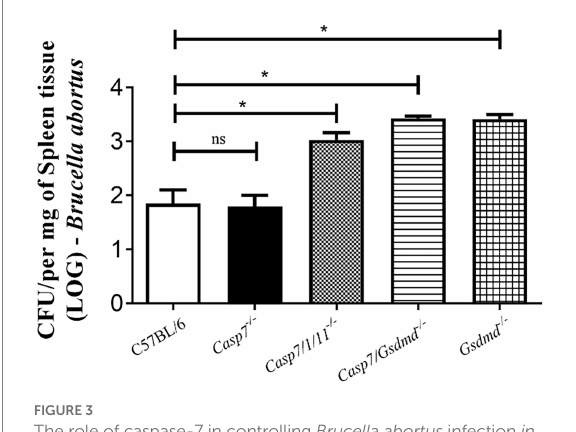
FIGURE 3 The role of caspase-7 in controlling Brucella abortus infection in vivo. Mice were infected intraperitoneally with 1 × 10 6 CFU of B. abortus and sacrificed after 2 weeks of infection, and spleen homogenates were seeded onto plates containing BB agar medium for CFU determination. Data shown are the mean ± standard deviation of five mice/group. The data are representative of three independent experiments. One-way ANOVA, * p < 0.05, compared to wild-type mice.